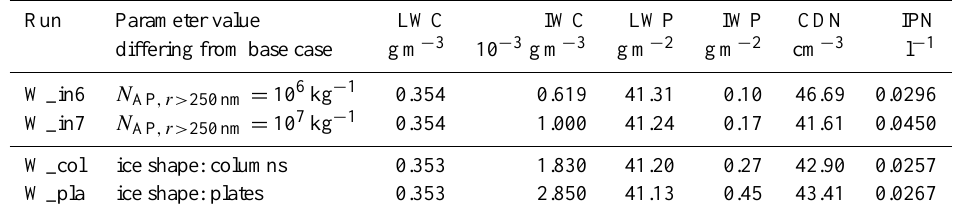
Figure 15. LWC (contours) and IWC (colors, logarithmic scale) for case 2. Comparison of different average updraft velocities w ave (upper left: C_w01, w ave = 0 . 1ms − 1 , right: C_w04, w ave = 0 . 4ms − 1 ) and the different stochastic realizations (lower left: C_r1, r1, right: C_r4, r4). Table 3. Overview of the model results for the microphysical sensitivity runs for the warmer case 1 (maximum values of L/IWC: liquid/ice water content, L/IWP: liquid/ice water path, CDN: cloud drop number, IPN: ice particle